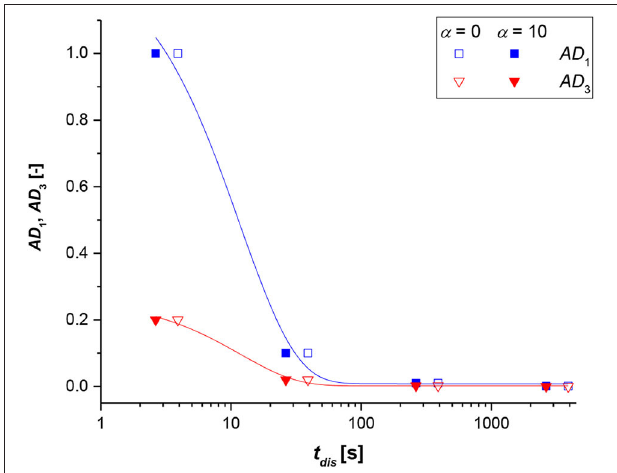
FIGURE 7 | Dimensionless numbers ( AD 1 blue symbols and line, AD 3 red symbols and lines) vs. the dissolution time ( t dis ) at α = 0 (no stirring, empty symbol) and α = 10 (high stirring value, full symbol), for a non-reactive